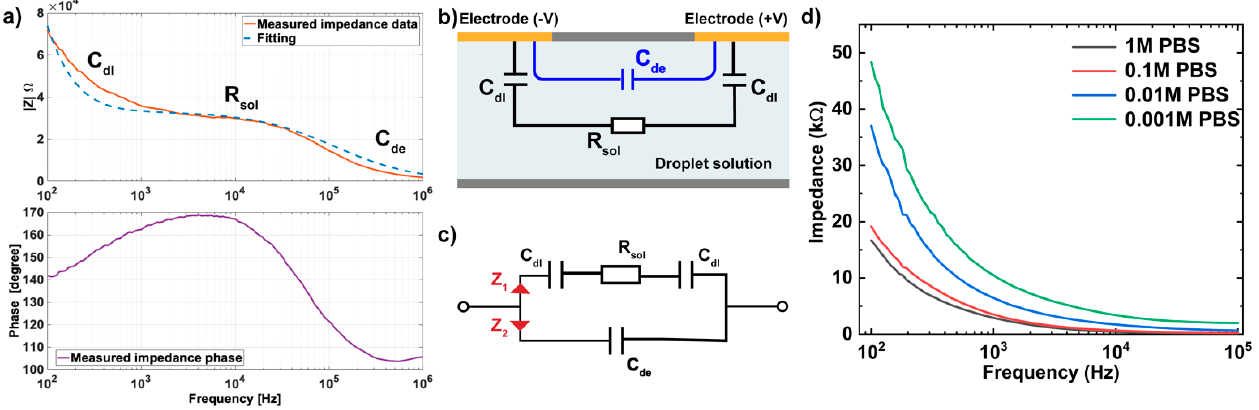
Figure 3. ( a ) The impedance magnitude of IDEs in DMF chip in DI water (non-faradaic regime) and the fitting curve came from Equations (1)–(3) with C dl = 48 nF, R sol = 33 k Ω , and C de = 42 fF. ( b ) Sim- plified electrical modeling and ( c ) equivalent circuit representing the electrode embedded in a DMF platform when a droplet is present. ( d ) Non-faradic electrochemical impedance spectroscopy (EIS) measured on the IDE in PBS buffer with different